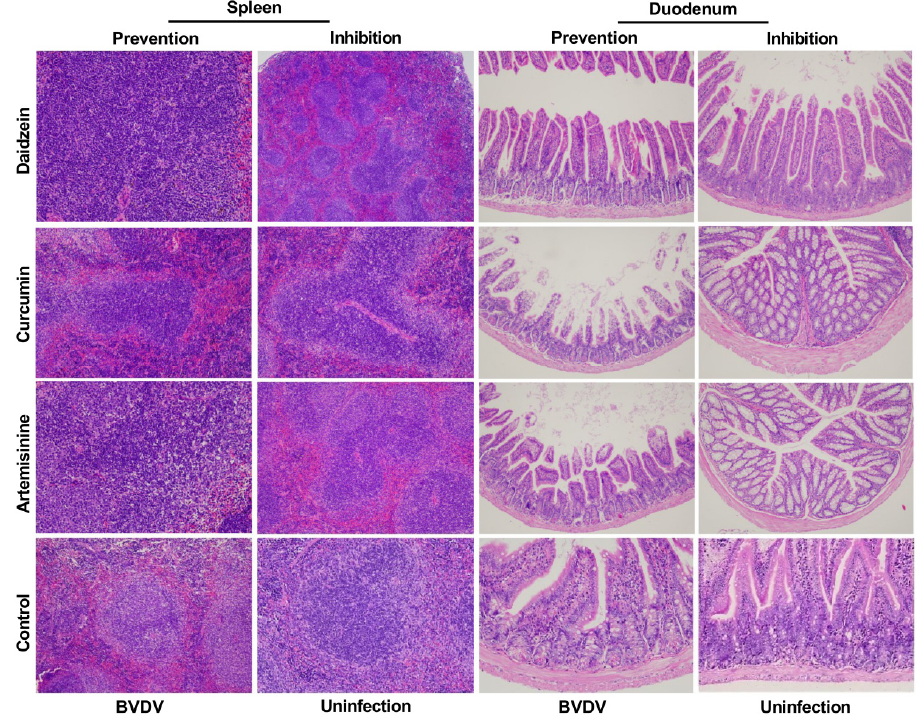
Figure 9. Results of pathological histological analysis. (Hematoxylin and eosin, original magnifica- tion, 200×).